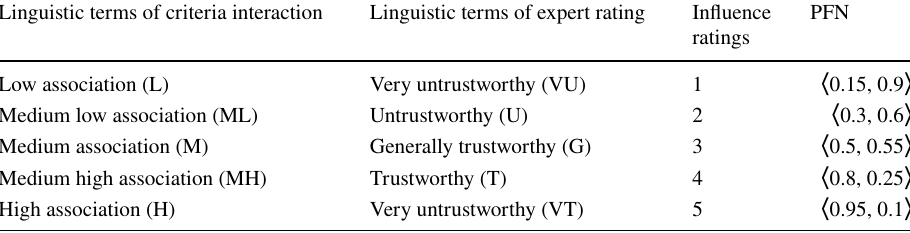
Table 2 Quantitative method of Linguistic terms of criteria interaction Linguistic terms of expert linguistic information [32]